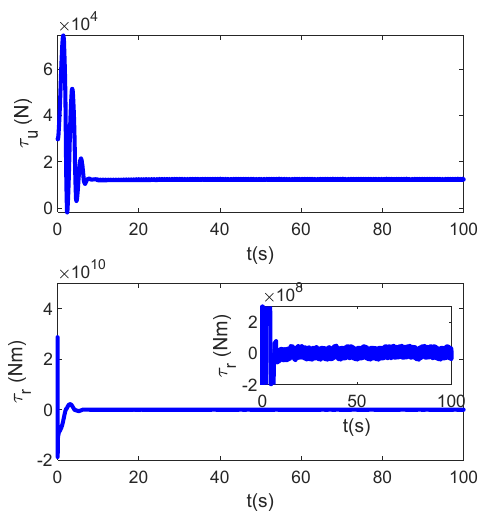
Figure 6. The yaw moment and surge force in curved ‐ line path following.